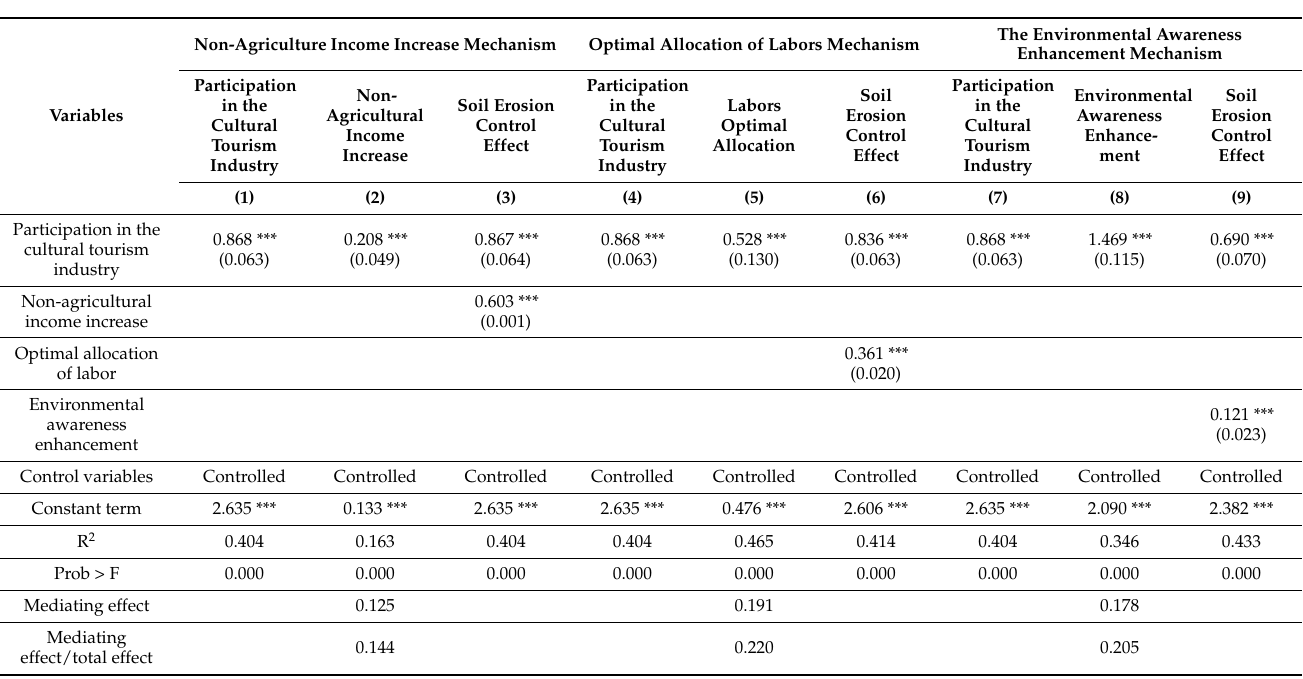
Table 6. Results of mechanism